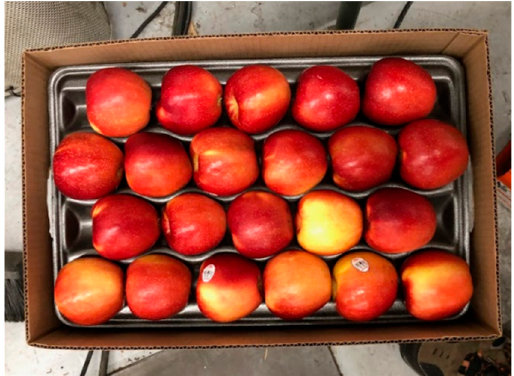
Figure 1. Arrangement of apples in molded pockets prior to testing.